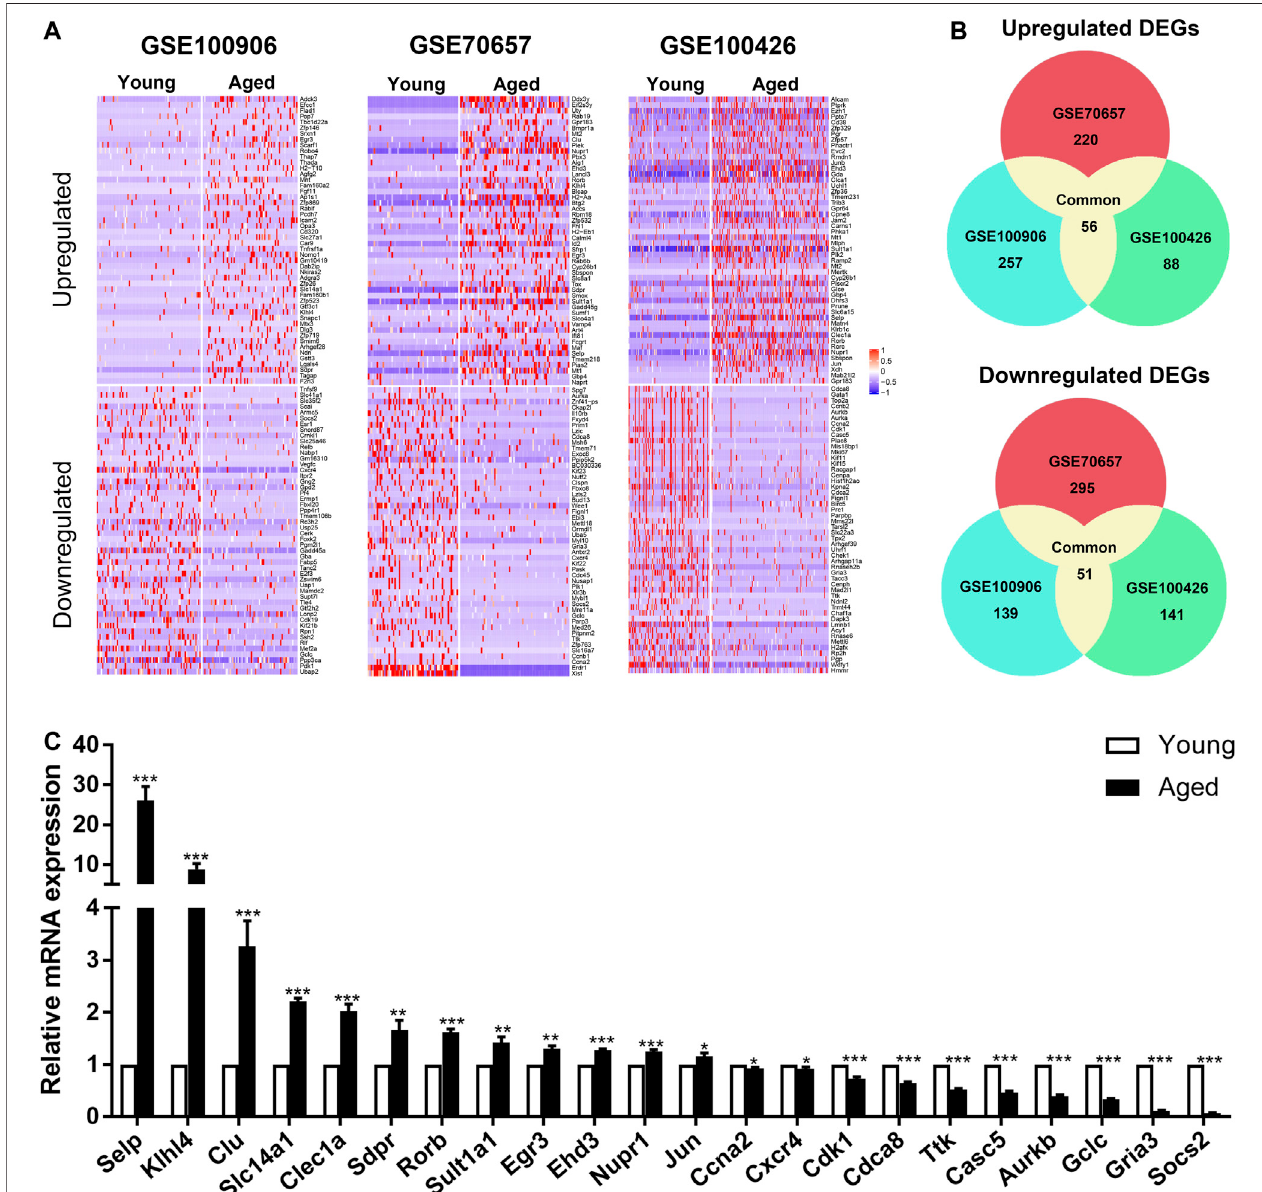
FIGURE 2 | Identi fi cation of common differentially expressed genes (DEGs) in 3 independent single-cell transcriptome datasets (GSE100906, GSE70657, and GSE100426). (A) Heatmap of the top 100 DEGs (50 upregulated and 50 downregulated genes). (B) Common DEGs in the three datasets (56 upregulated and 51 downregulatedgenes). (C) qRT-PCRresultsoftherelative geneexpression oftop30DEGs.Dataarepresentedasthemean ± SEM.* p < 0.05;** p < 0.01; *** p <